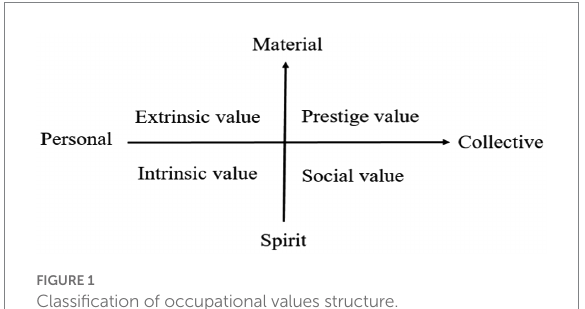
FIGURE 1 Classification of occupational values